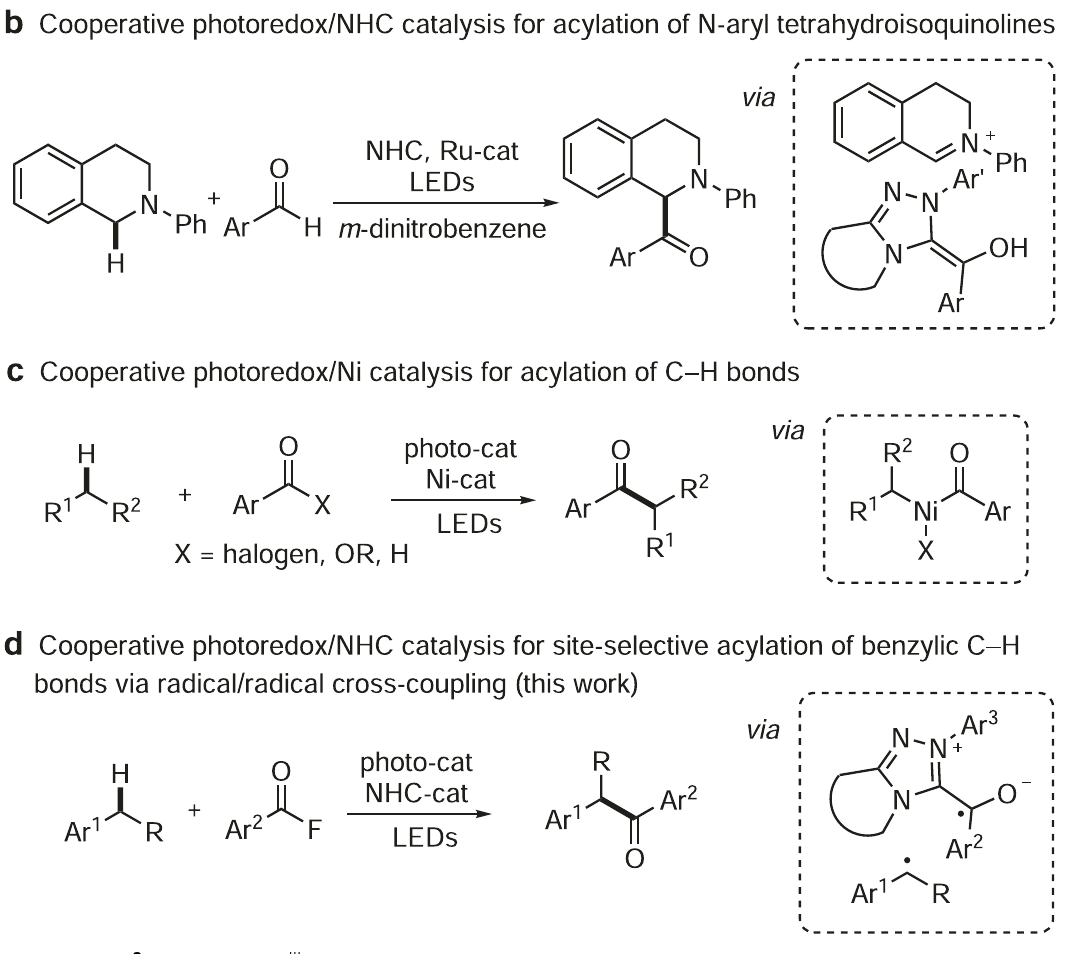
Fig. 1 Direct acylation of sp 3 C-H bonds. a Rh III -catalyzed benzylic C-H acylation of 8-methylquinoline. b Cooperative photoredox/NHC catalysis for acylation of N -aryl tetrahydroisoquinolines. c Cooperative photoredox/Ni catalysis for acylation of C – H bonds. d Cooperative photoredox/NHC catalysis for site-selective acylation of benzylic C – H bonds via radicals cross-coupling. NHC N-heterocyclic carbene, LEDs light-emitting diodes, Rh rhodium, Ru-cat ruthenium catalyst, Ni-cat nickel